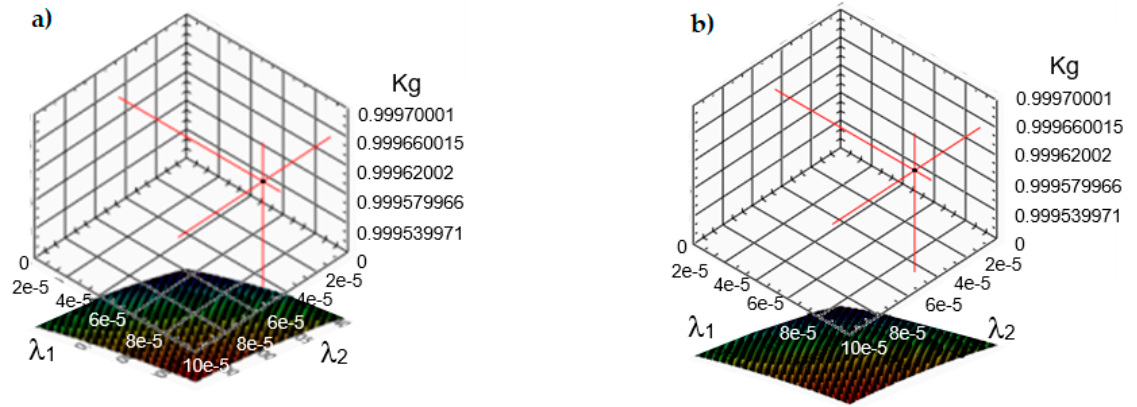
Figure 6. Graphs of the K g availability coefficient in the process of testing the reliability of wind farm devices by changing the value of the average repair time for constant parameters, including: type I mean service time = 0.8 [h]; type II mean operating time = 1.3 [h]; mean time between successive